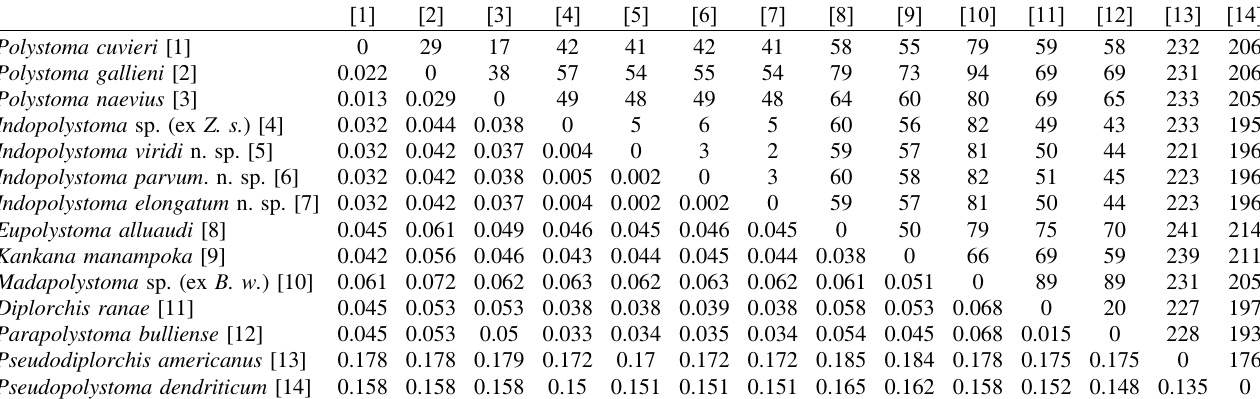
Table 3. Matrix of 28S p -distances (lower left) and total differences (upper right) inferred from pairwise comparisons in MEGA7. B. w. refers to B. wittei and Z. s. to Z. smaragdinus . See also Table 1 for other host